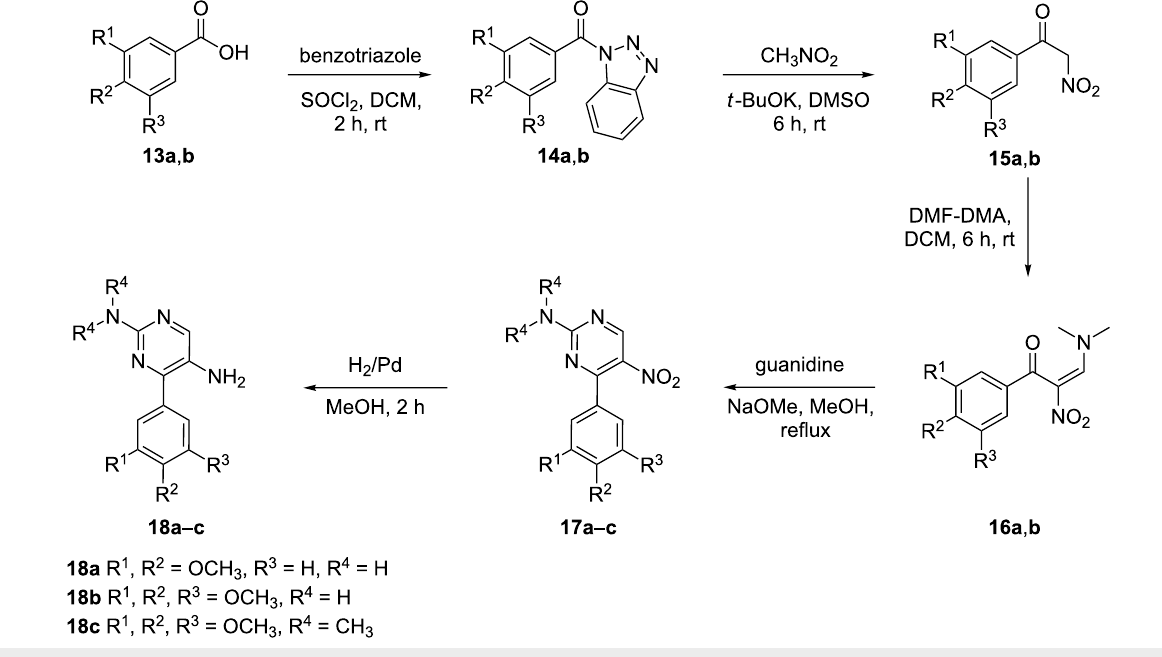
Scheme 6: Synthesis of substrates 18a–c for the modified Pictet–Spengler